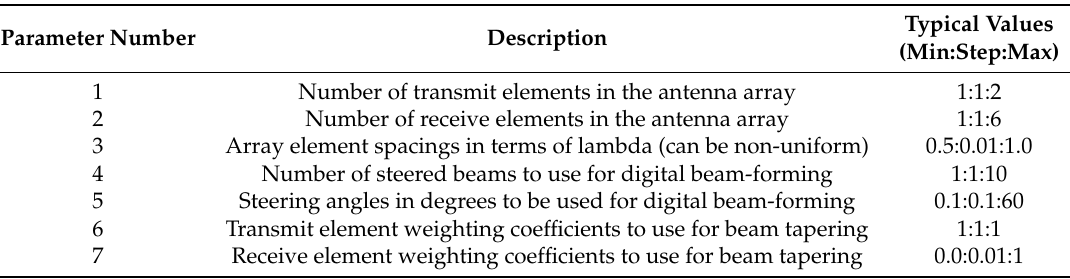
Table 2. GA objective function parameters (genes).